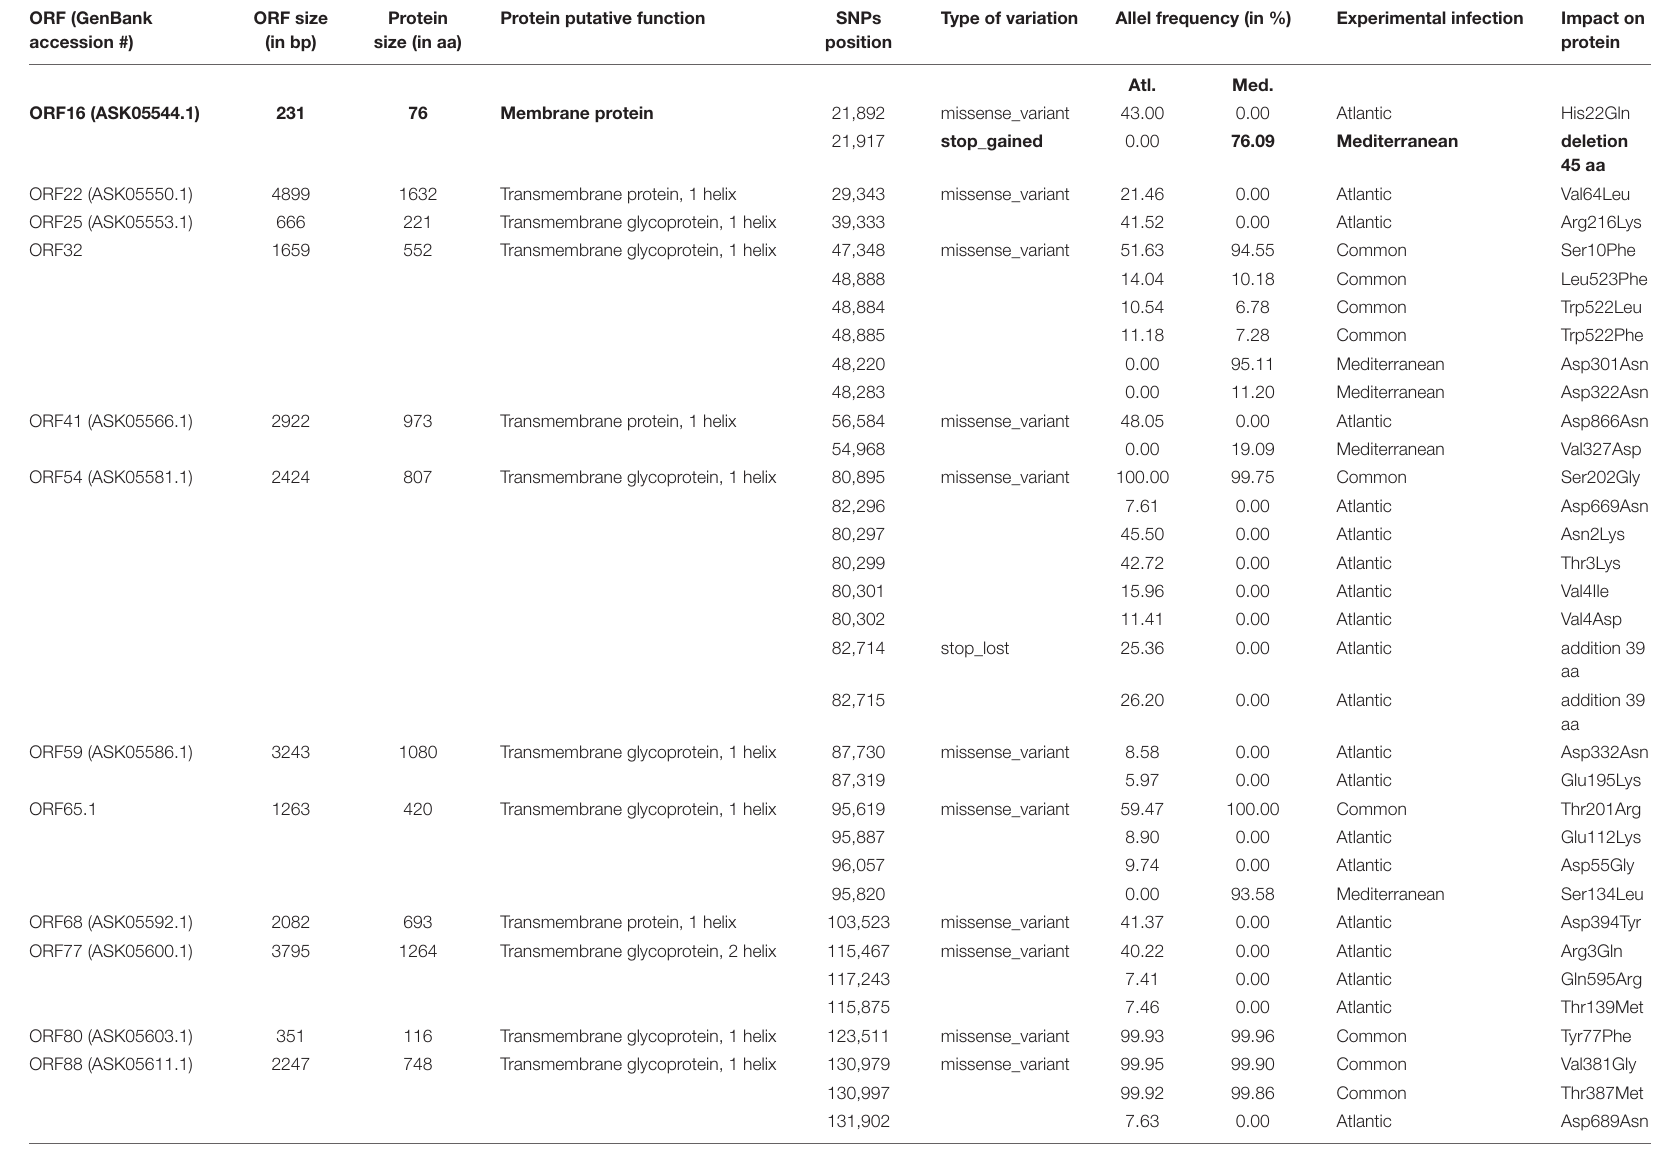
TABLE 1 | ORFs encoding membrane related proteins carrying